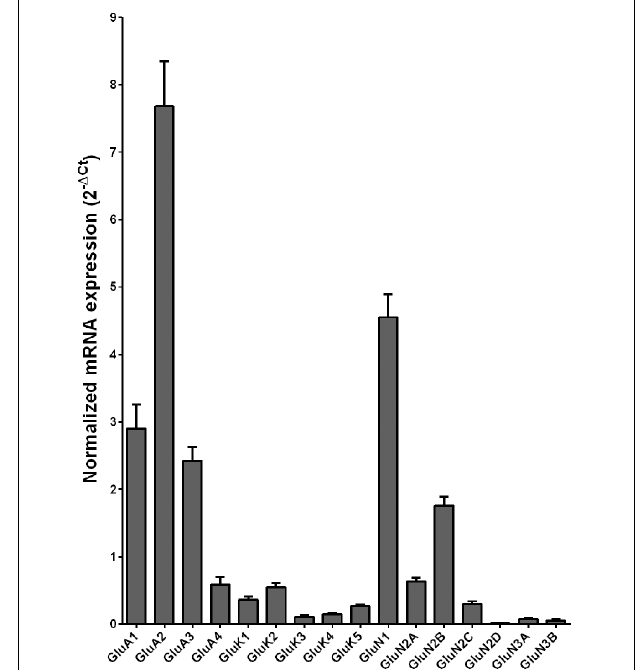
FIGURE 1 | Expression of ionotropic glutamate receptor subunit mRNAs in the hippocampal dentate gyrus region from control subjects ( n = 15). The mRNA level of each subunit was normalized to reference genes ACTB and UBC and presented as mean ±